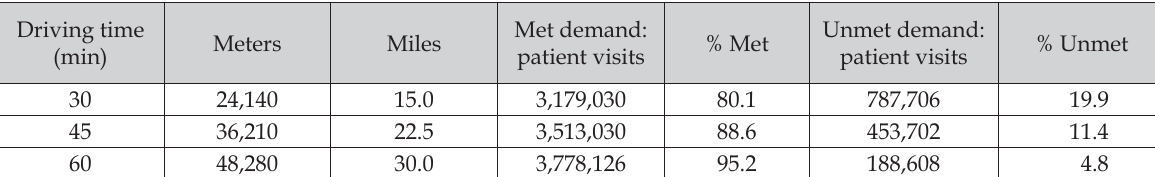
Table 1. Tract model